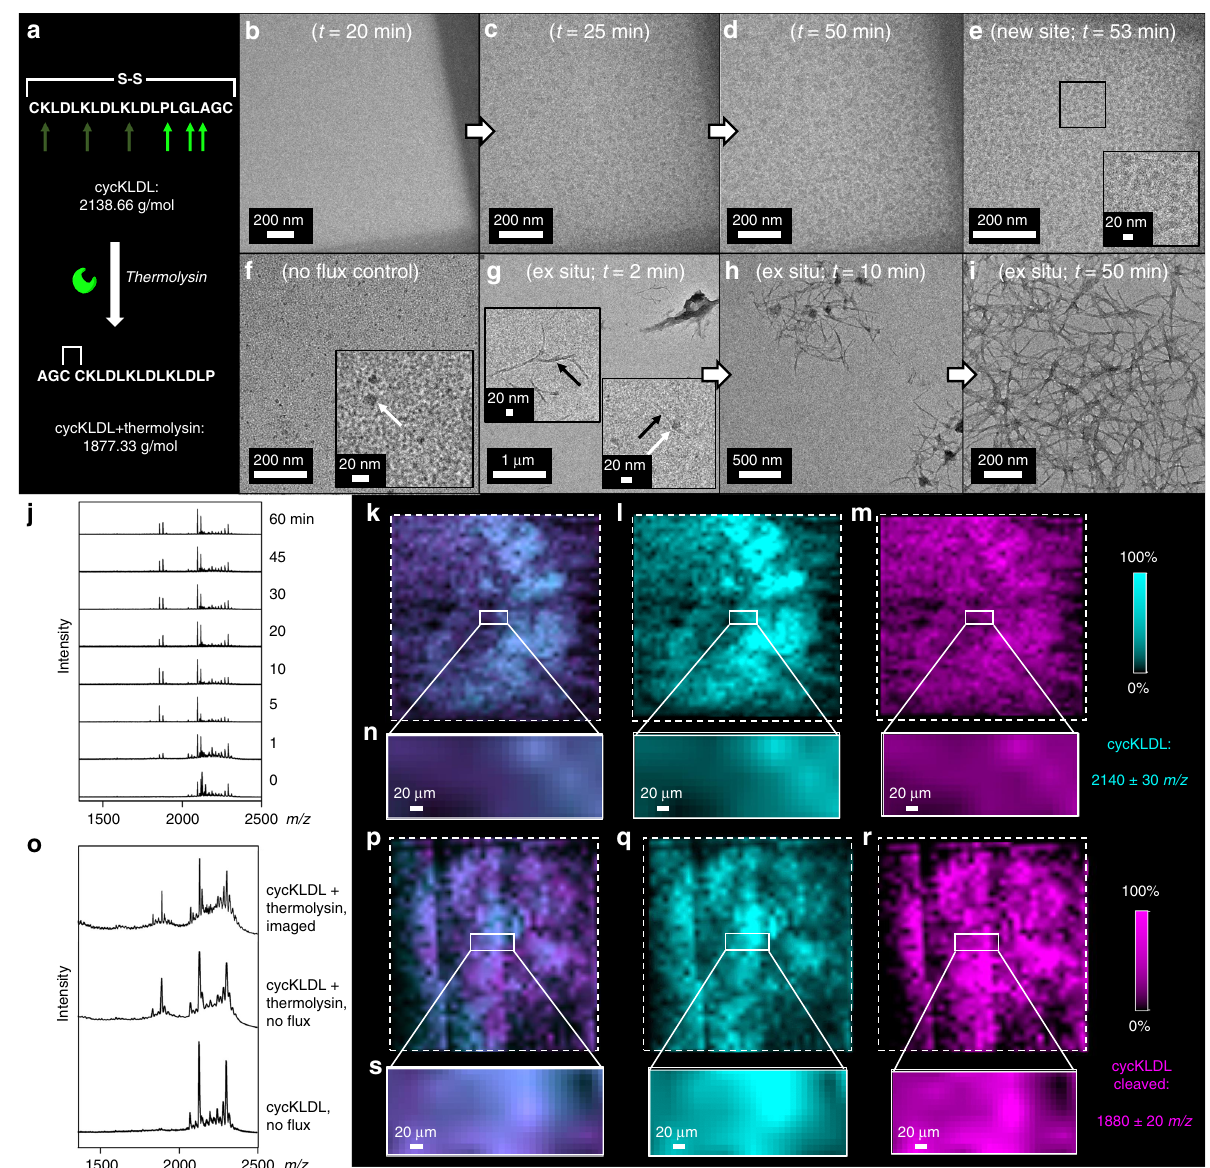
Fig. 8 Enzyme activation of cycKLDL to form nanoscale structures. a Schematic of enzyme-induced linearization of cycKLDL by thermolysin. Observed cleavage locations indicated with bright green arrows. b – d LCTEM images of a solution of cycKLDL and thermolysin acquired under low- fl ux, pulsed conditions, where t = 0 corresponds to initial mixing of cycKLDL and thermolysin prior to liquid cell assembly. Images were acquired every 5 min. e Image of other corner of the same liquid cell shown in b – d , which had not been previously irradiated. f Dry-state image of particles on a SiN x chip that was part of a liquid cell assembly that served as a no fl ux enzyme cleavage control experiment. White arrow denotes spherical nanoparticle. g – i Dry-state, uranyl acetate-stained TEM images of cycKLDL and thermolysin ex situ reaction mixture at various time points. White arrow denotes spherical nanoparticle. Black arrows denote fi bers. j MALDI spectra of cycKLDL and thermolysin ex situ reaction mixture at various time points up to 60 min. k – m MALDI-IMS mapping of the surface of a chip from the LCTEM experiment shown in b – d , with different m/z fi lters applied. n Zoom-in of rectangular window regions of chips shown in k – m with applied m/z fi lters. o Averaged MALDI spectra of window region of an LCTEM chip, which had been assembled as a liquid cell containing cycKLDL with no fl ux (bottom), window region of an LCTEM chip, which had been assembled as a liquid cell containing cycKLDL and thermolysin solution and incubated for 1 h with no fl ux (middle), and window region of LCTEM chip containing cycKLDL and thermolysin solution after imaging by LCTEM under low- fl ux, pulsed conditions (top). p – r MALDI-IMS mapping of the surface of a chip that had been assembled into a liquid cell containing cycKLDL, but was not irradiated with the electron beam, as a no fl ux control. s Zoom-in of rectangular window regions of chips shown in p – r with applied m/z fi lters. Filter colors are displayed as 0 – 100% of integrated intensity on a logarithmic scale within the analyzed region. Source data